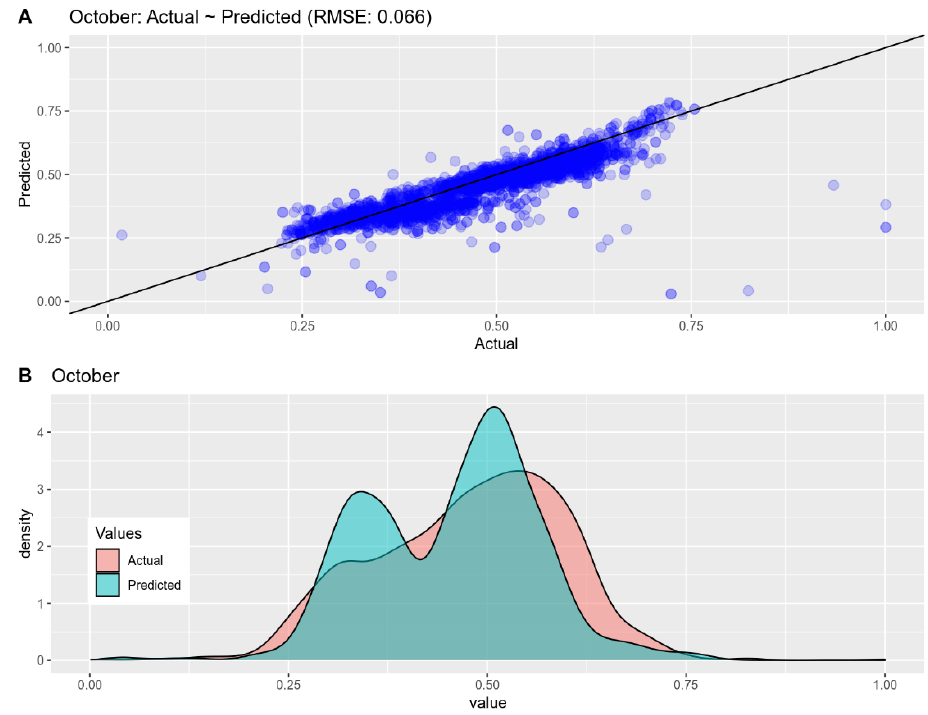
Figure A10. Comparison between actual~predicted for October 2020.